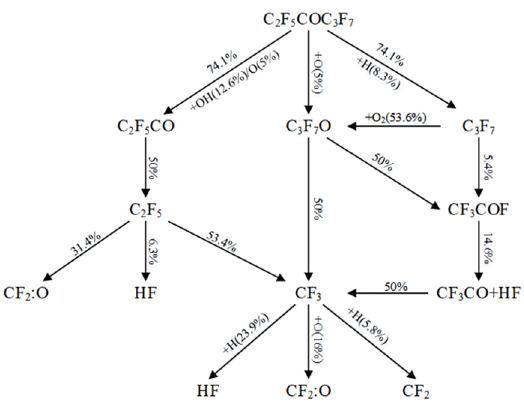
Figure 6. Reaction path of FK-5112 in methane/air premixed flame [75]. Adapted with permission from Ref. [75]. 2016, SAGE